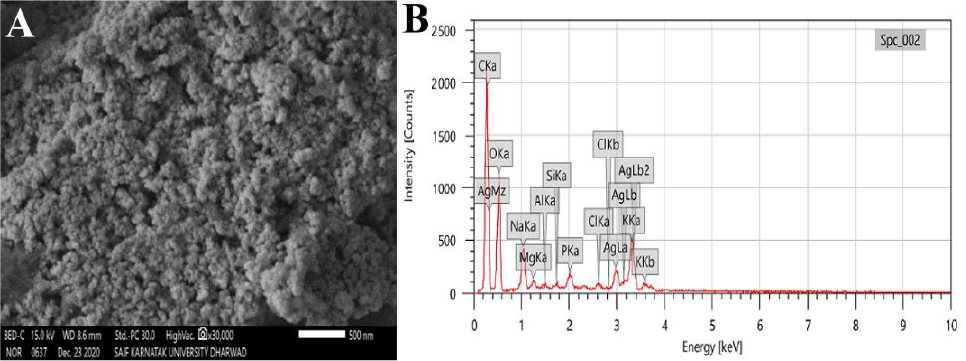
Figure 5. ( A ) SEM image and ( B ) elemental mapping spectrum of synthesized RsFb-AgNPs.